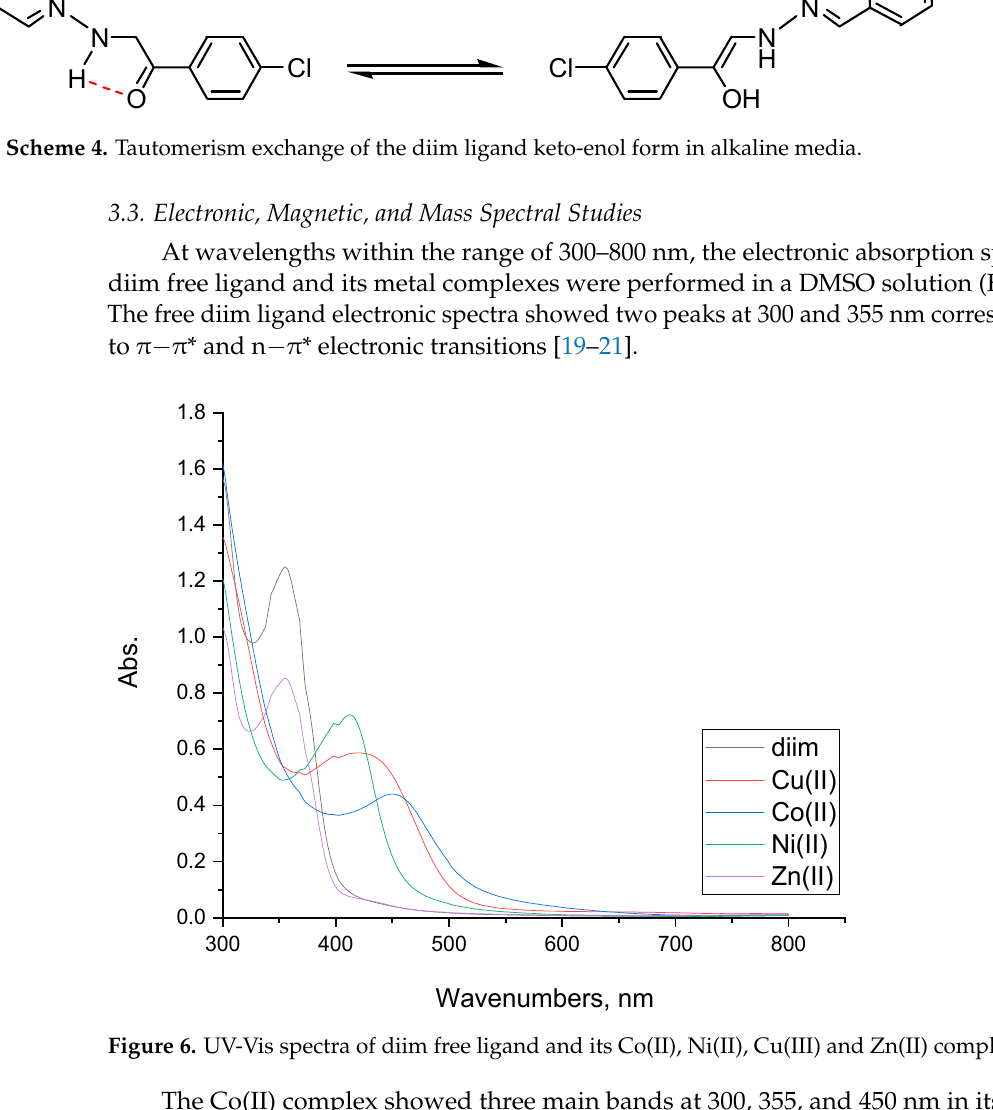
ClNNO HH H Scheme 4. Tautomerism exchange of the diim ligand keto-enol form in alkaline media.